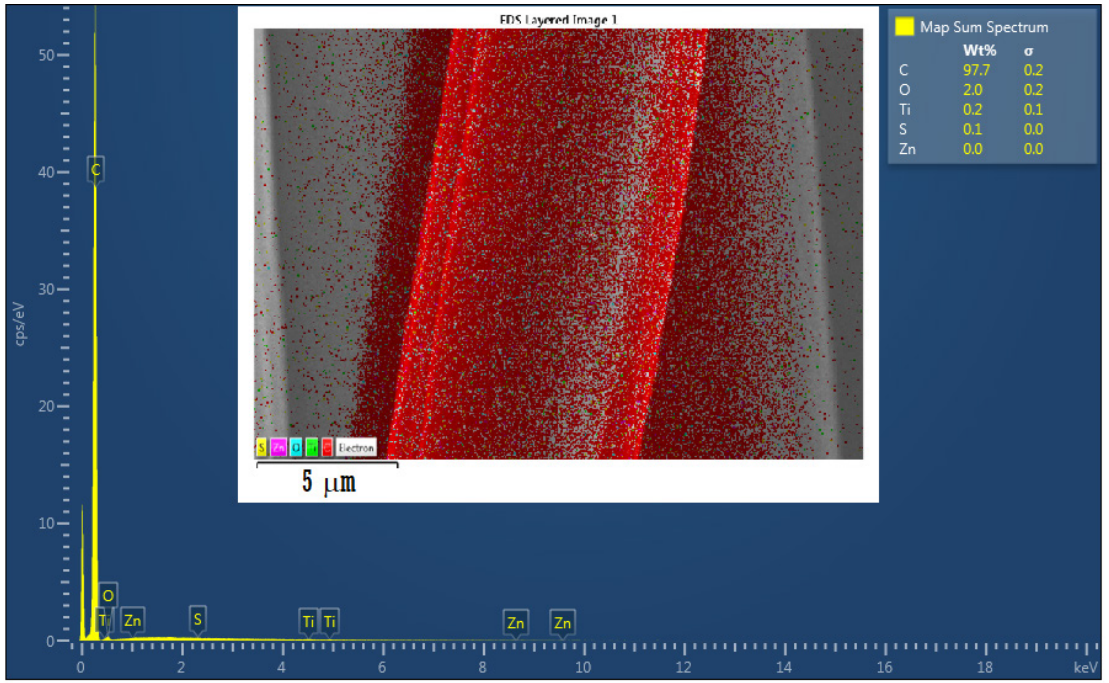
Figure 3: The EDX analysis result of TiO